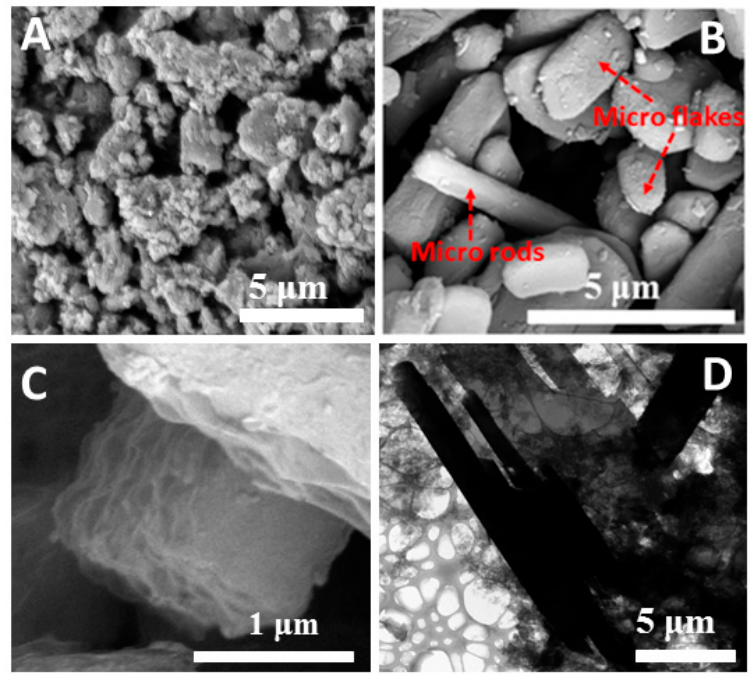
Figure 2. SEM images of the microstructures of the aniline oligomers formed in the presence of reaction media: ( A ) water and ( B ) ethanol. TEM images of ( C ) micro flakes and ( D ) micro rods formed in the presence of ethanol.